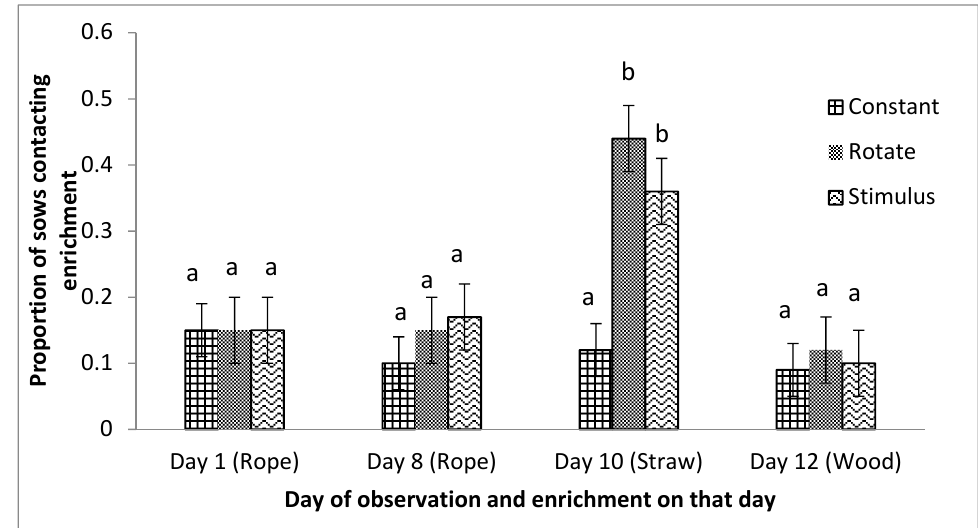
Figure 5. Proportion of sows contacting enrichments (rope, wood or straw) and day of observation (days 1, 8, 10 and 12) in the Constant, Rotate and Stimulus treatments. Note: sows in the Constant treatment received the wood enrichment on all days. Sows were observed during an 8 hour period (08:00–16:00 h) on four days (1, 8, 10 and 12) using time lapse photos at 10 min intervals. Bars without a common superscript are significantly di ff erent ( p < 0.05). ab LSMeans with a di ff erent superscript are significantly di ff erent ( p < 0.05). Table 3. E ff ects of enrichment treatment and day of observation on the postures of sows observed in photo scans *. LS Means of duration (proportion of observations) and number of sows in each posture (proportion of